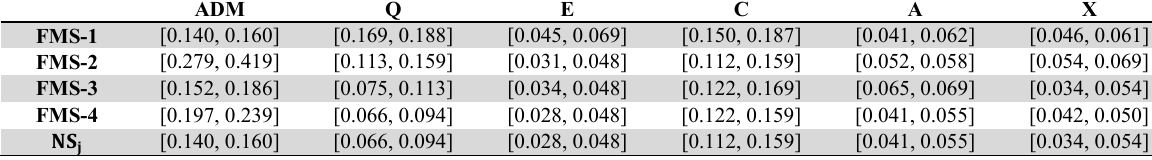
Interval valued weighted decision matrix and interval valued negative-ideal solution ADM